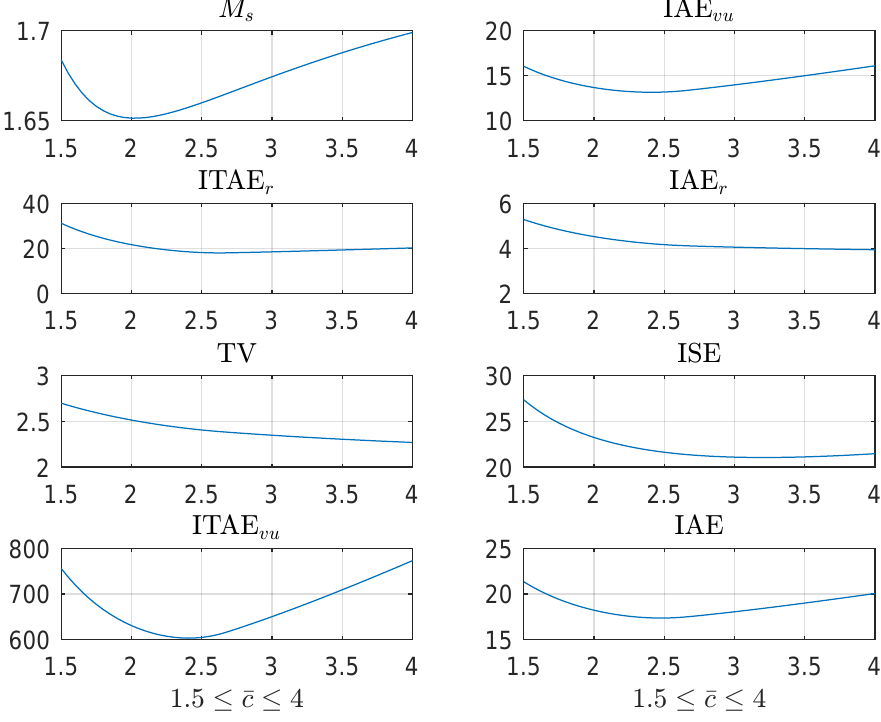
Figure 4. Consider PI control of an IPTD process, H p ( s ) = k e − τ s τ = 1. PI controller H c ( s ) = K p 1 + T i s